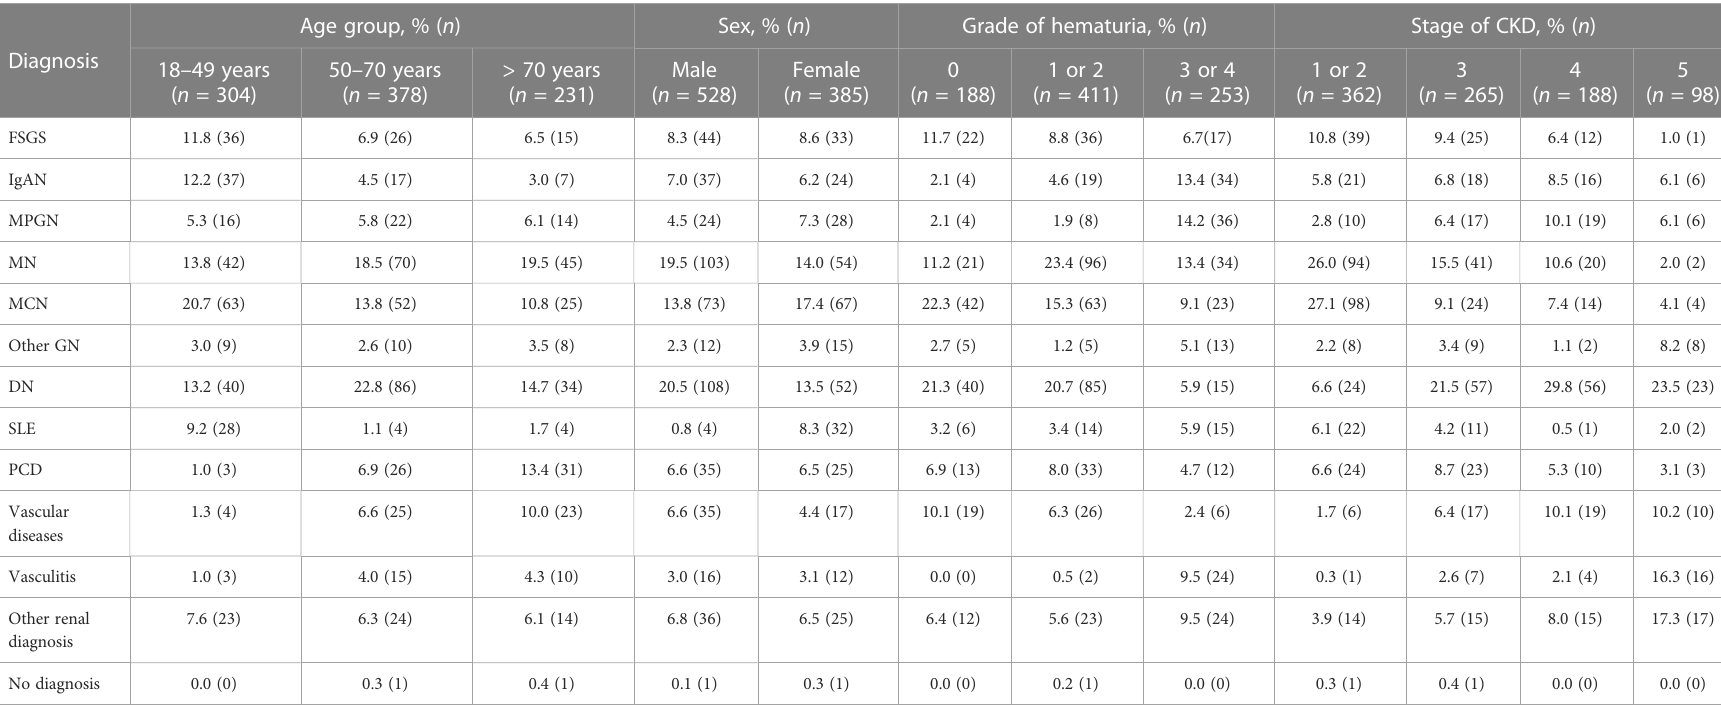
TABLE 4 Causes of NS in different subgroups based on age, sex, grade of hematuria, and CKD.